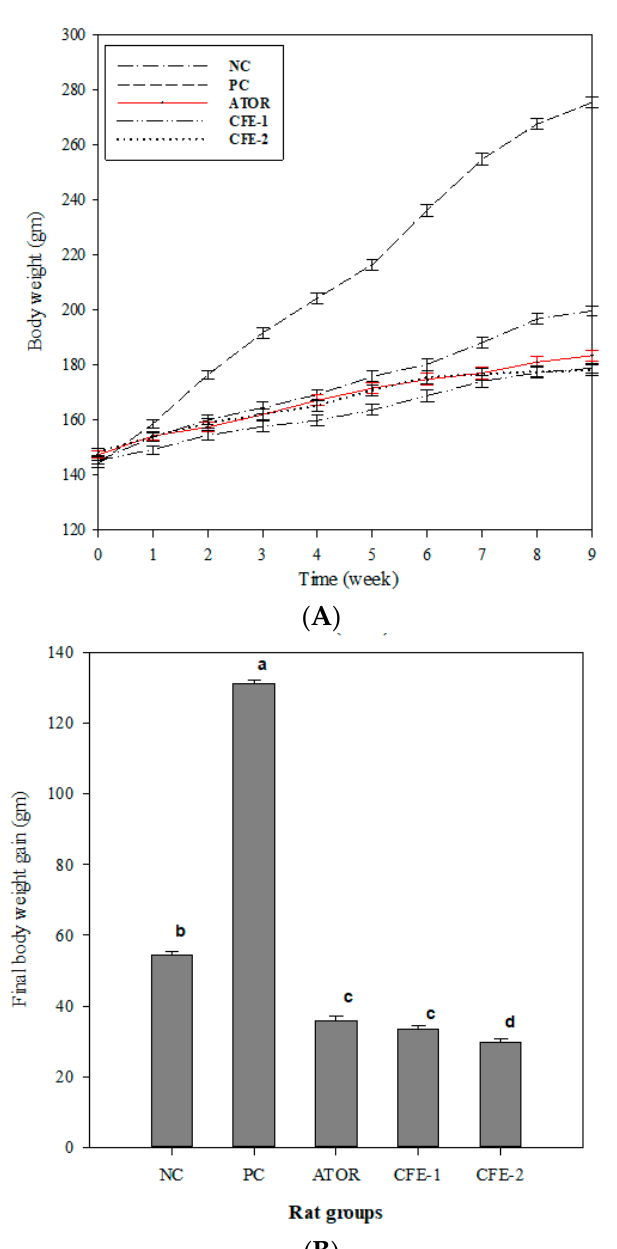
Figure 3. Body weight curve ( A ) and final body weight gain ( B ) through a 9-week experimental period of male Wistar Albino rats. Group 1 received a normal diet (Negative control: NC). Groups 2–5 received a high-fat diet, where group 2 did not receive any further treatment (Positive control: PC). Group 3 was treated with atorvastatin (ATOR) (10 mg kg − 1 ), while groups 4 and 5 were treated with Lactobacillus paracasei postbiotic (CFE-1 and CFE-2; at 100 and 200 mg kg − 1 , respectively). Values are presented as mean ± SD ( n = 8). Mean values within the same histogram with different superscripts letters are significantly different ( p < 0.05). Number of animal equal 40 animals (five groups of 8 animals each). Postbiotic is the cell-free extract (CFE).